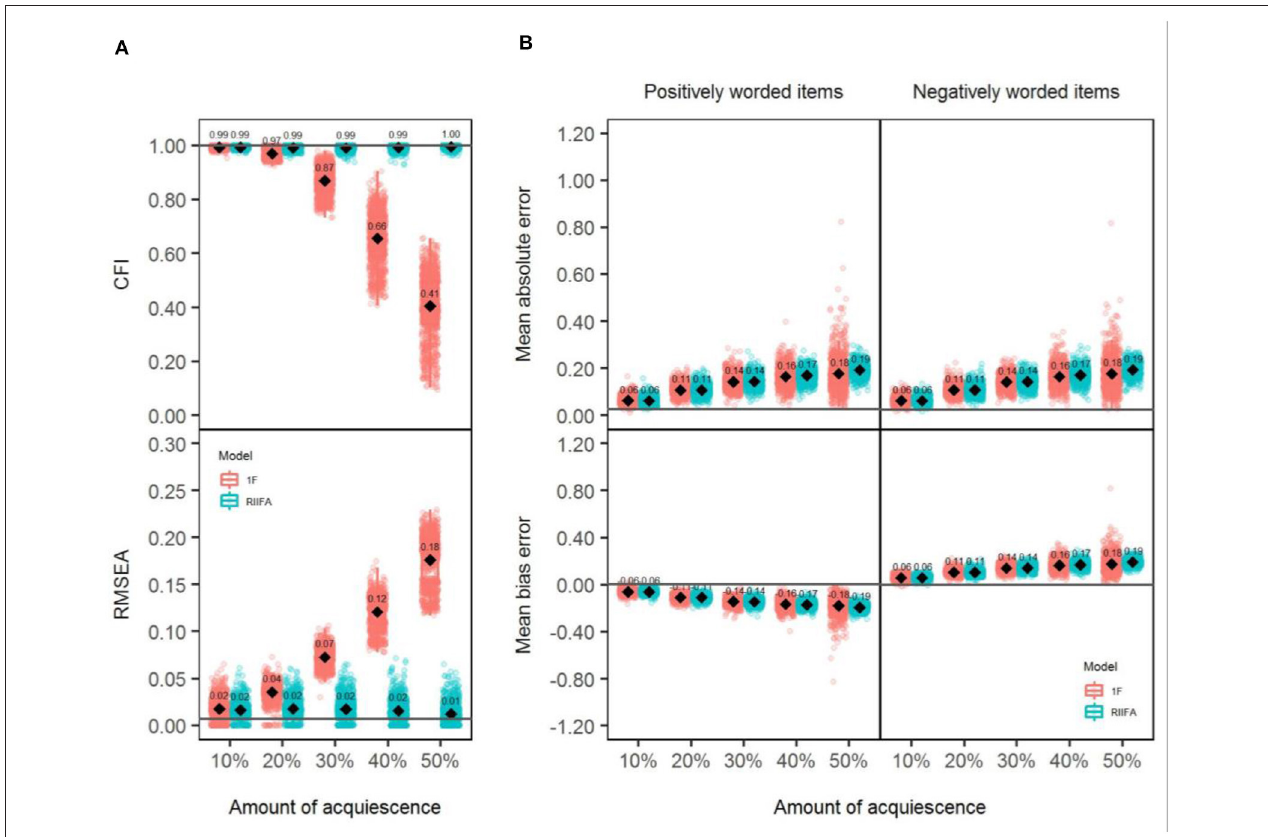
FIGURE 8 | Model fit and recovery of substantive factor loadings for the 1F model and the RIIFA model in the presence of acquiescence. 1F, unidimensional model with one substantive factor; RIIFA, random intercept item factor analysis model with one substantive factor and one wording method factor. In (A) , the horizontal gray lines represent the mean CFI and RMSEA values for the condition with 0% of wording effect. In (B) , the horizontal gray lines represent the mean absolute error and the mean bias error on average for the condition with 0% of wording